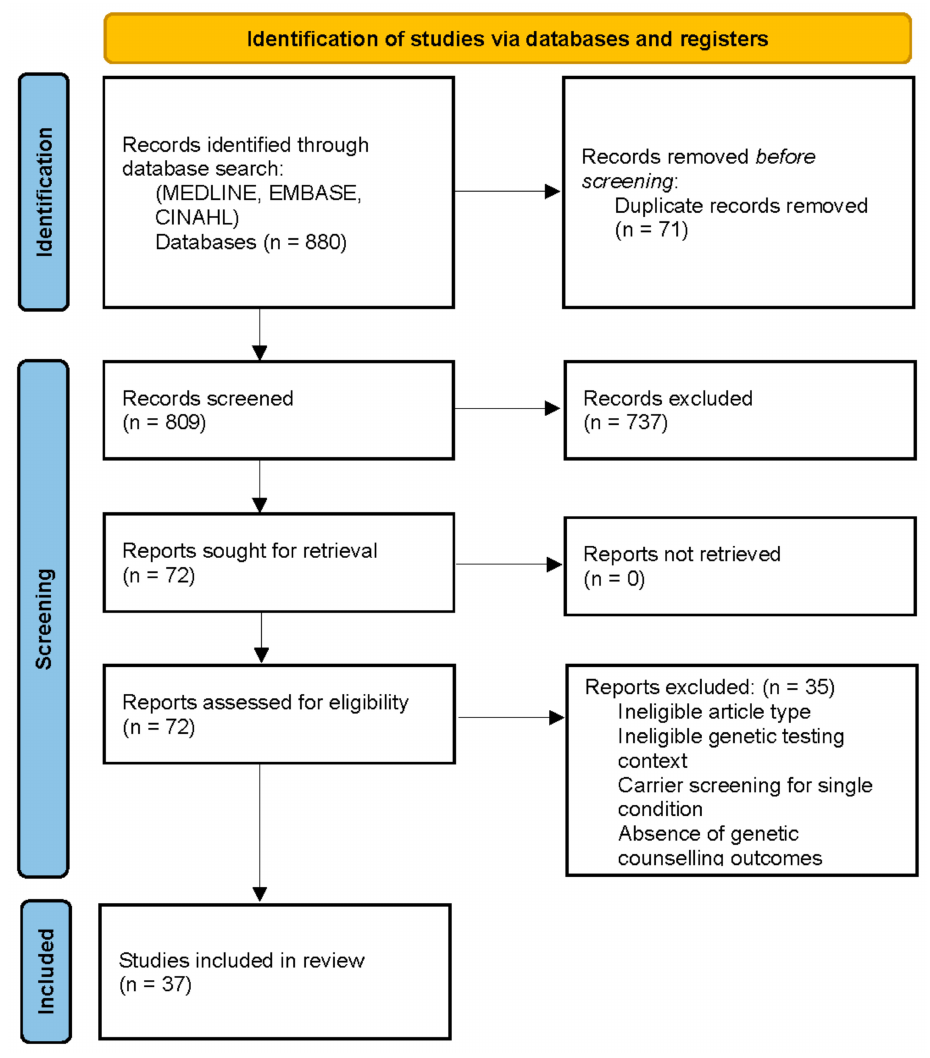
Figure 1. PRISMA flow diagram for the scoping review of genetic counselling needs of reproductive genetic carrier screening. Adapted from Page et al PRISMA 2020 Statement [23]. Table 1. General characteristics of included studies ( n =